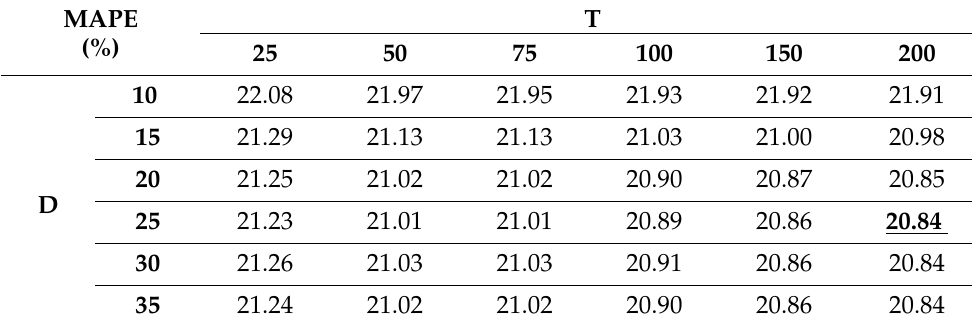
Table 5. Performance comparison between Random Forest